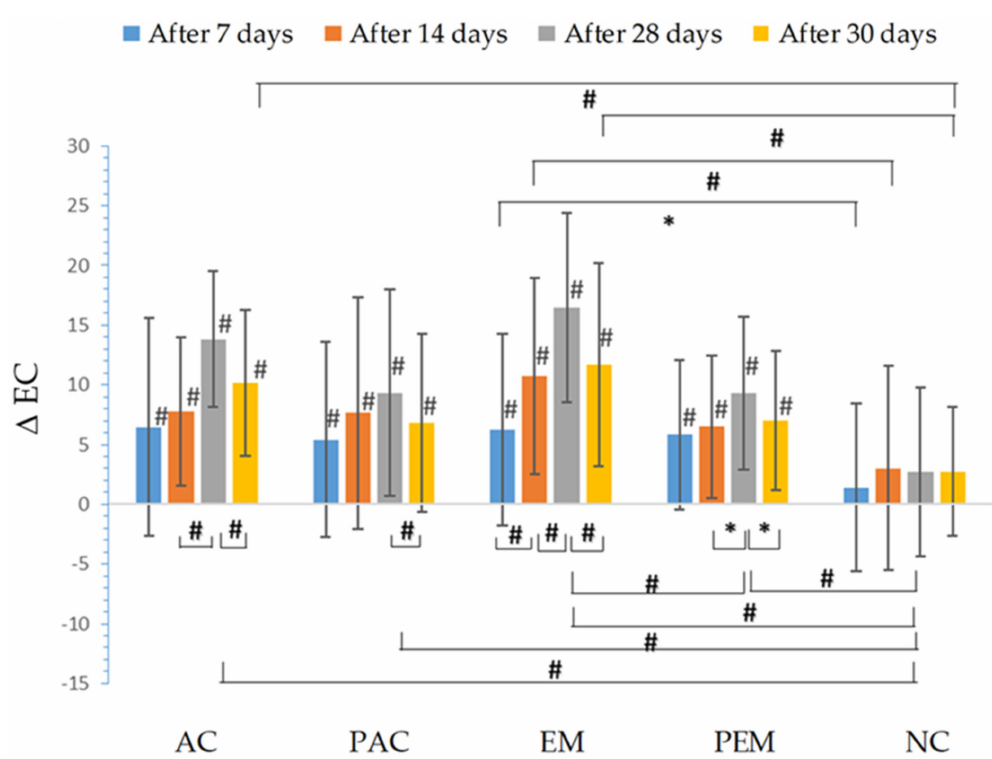
Figure 2. In vivo determined absolute changes relative to basal values of electrical capacitance (EC) for investigated creams (active cream—AC, placebo cream—PAC) and emulgels (active emulgel— EM, placebo emulgel—PEM) after 7, 14, and 28 days of application, and 2 days after cessation of application. Significant differences are marked with # ( p < 0.01) and * ( p <